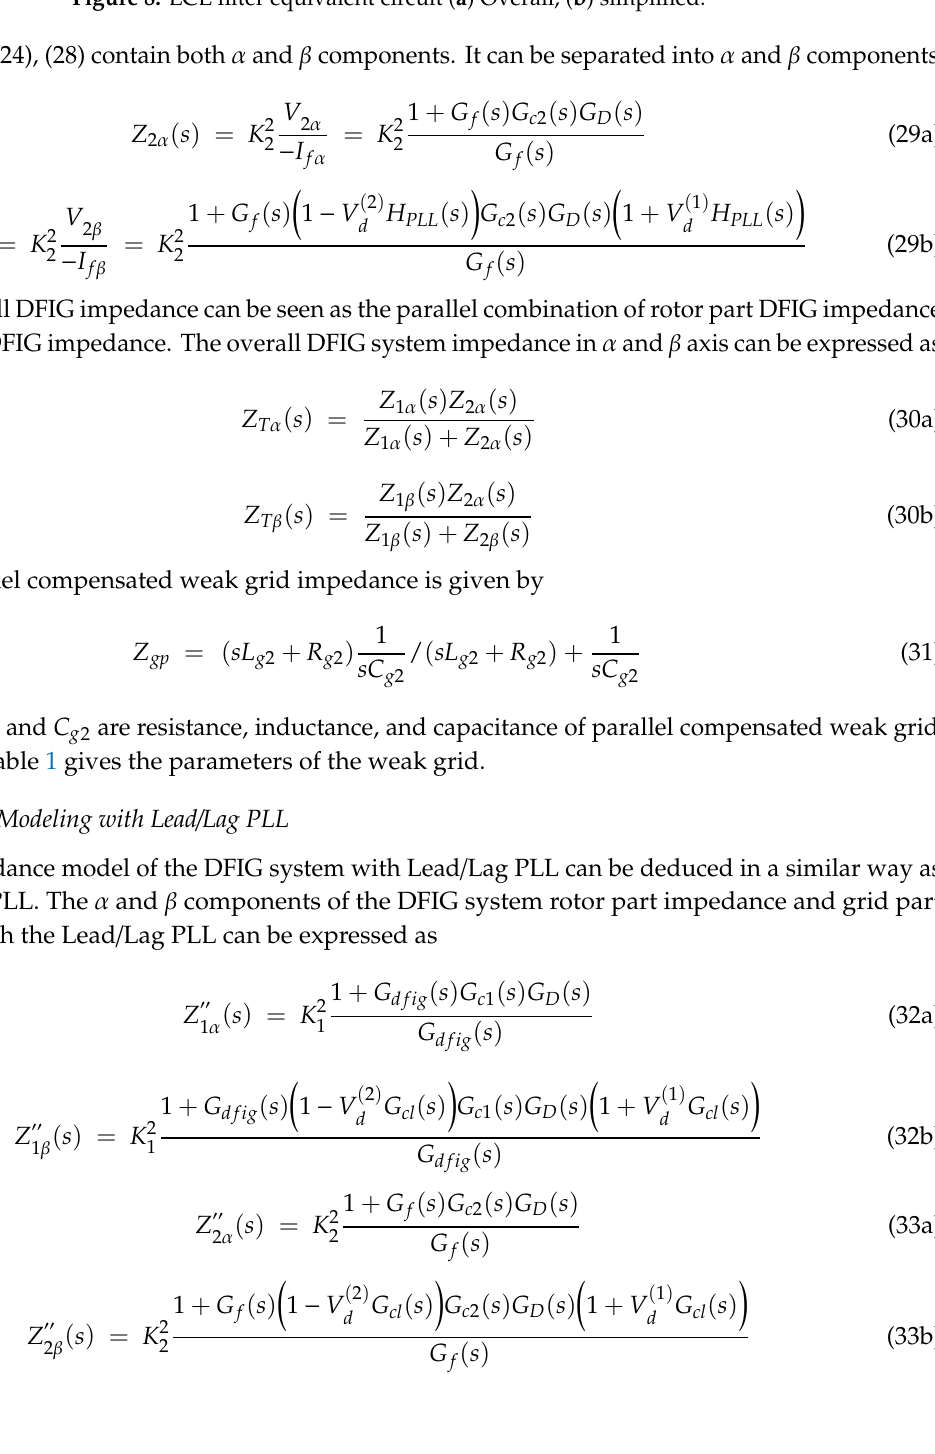
Figure 8. LCL filter equivalent circuit (a) Overall; (b) simplified.